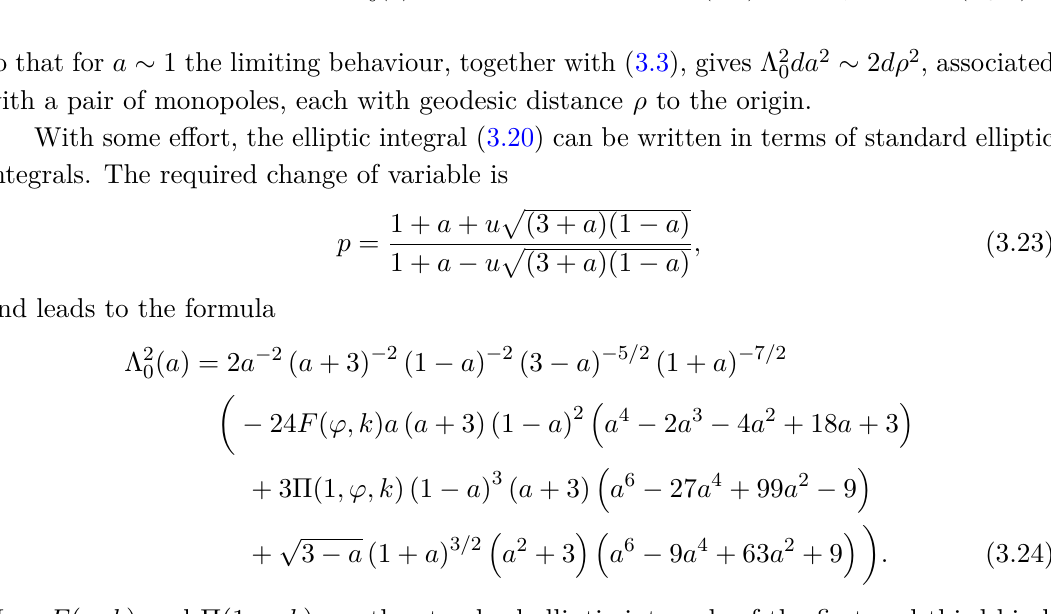
( a ) with octic approximation (left), and asymptotics (right). 0